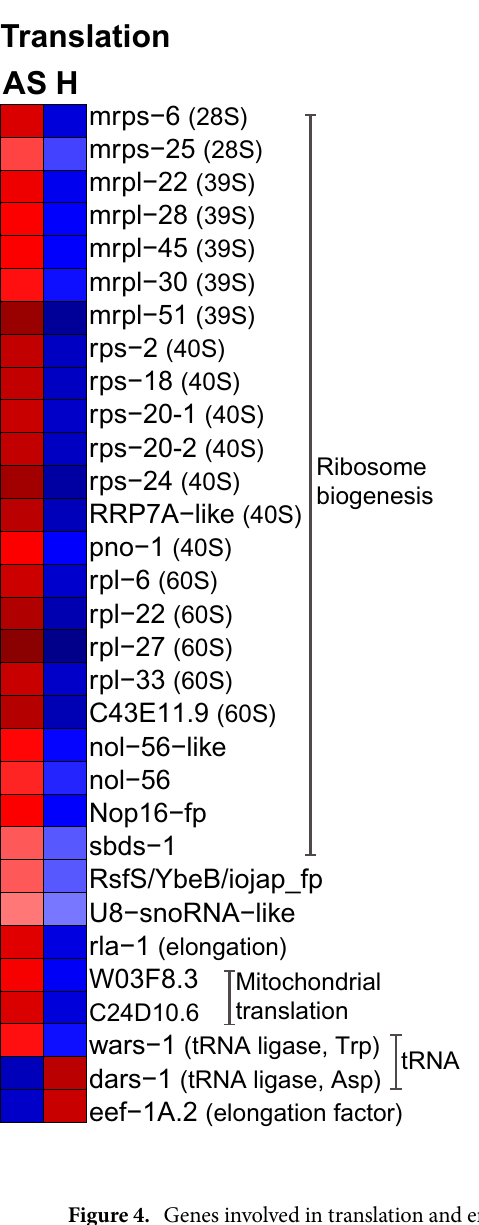
Figure 4. Genes involved in translation and energy generation and genes encoding for C-type lectins and mucins were predominantly expressed in AS worms. Heatmap displaying genes upregulated in AS (anoxic sulfidic) relative to H (hypoxic) worms, upon 24 h-long incubations under one of the two conditions (1.5- fold change, FDR ≤ 0.05). Expression levels are displayed as mean-centered log 2 TPM values (transcripts per kilobase million). Genes are ordered by function in their respective metabolic pathways. For each process, the minority of genes that were upregulated in H worms is shown in Data S1. Red denotes upregulation, and blue downregulation. Fp, family-containing protein; Cytoch. C ox. su. II: cytochrome c oxidase subunit II; Ubiq./ rhodoq biosynth.: Ubiquinone or rhodoquinone